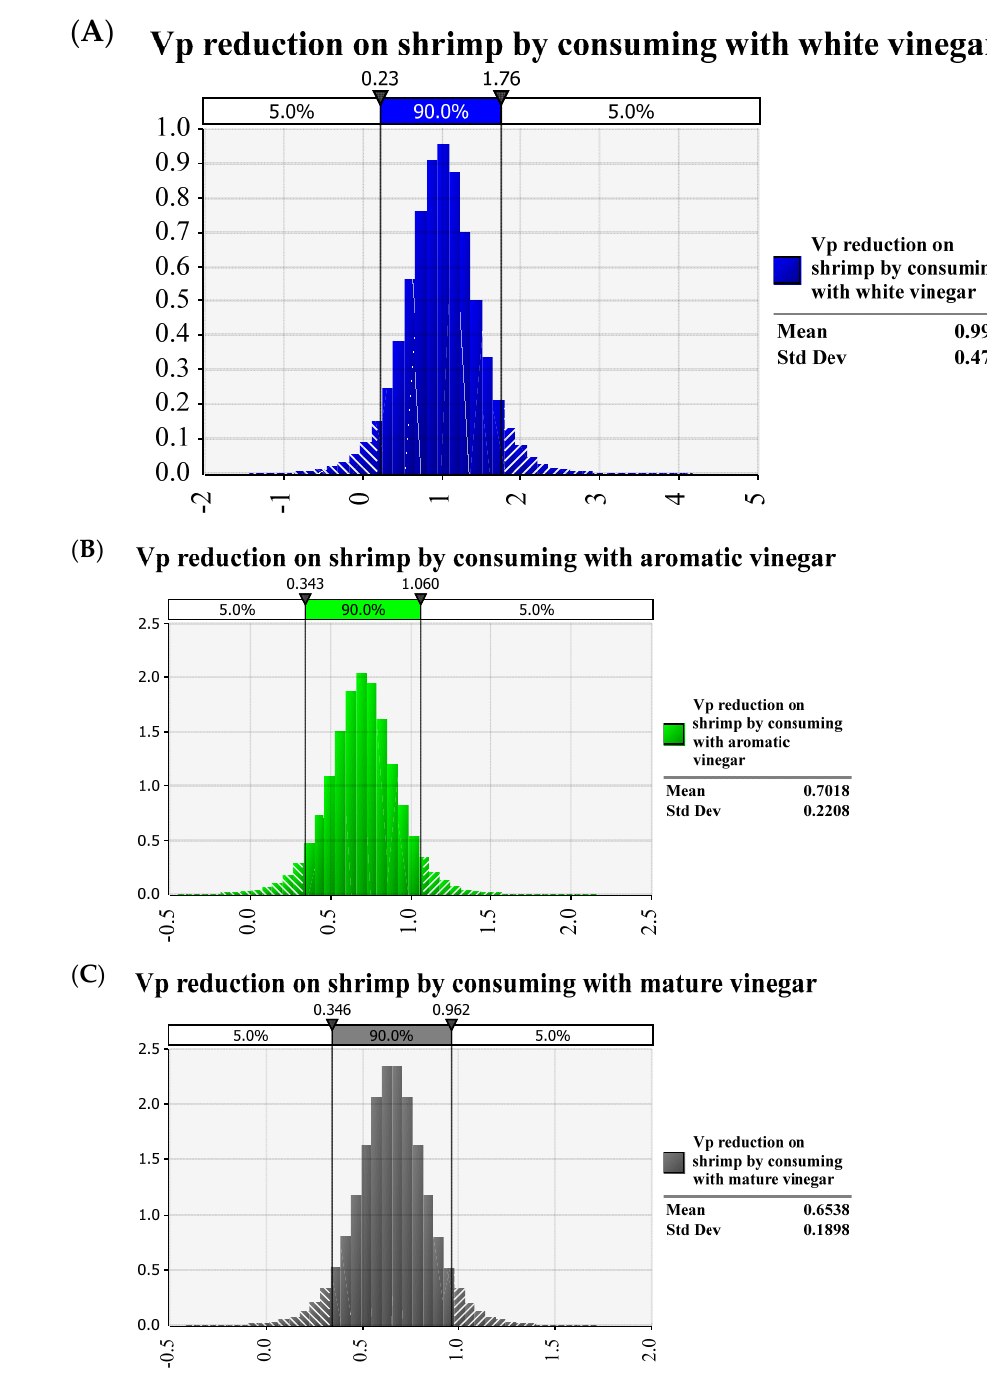
Figure 2. The reduction of V. parahaemolyticus contamination level on ready − to − eat shrimp by consuming with white vinegar ( A ), aromatic vinegar ( B ) and mature vinegar ( C ). Note: Vp = Vibrio parahaemolyticus.